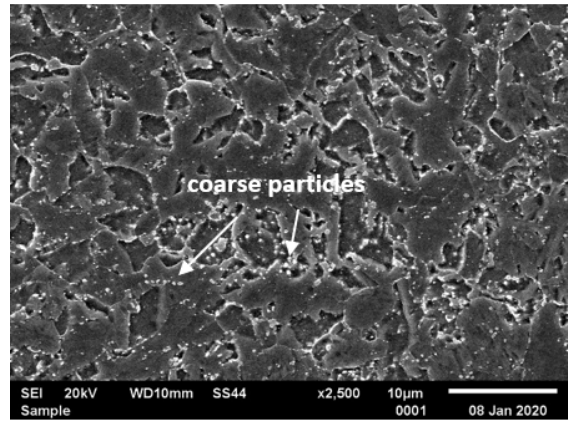
Figure 9. Microstructure of FGHAZ/ICHAZ in T115 steel joint—joint No. 2.